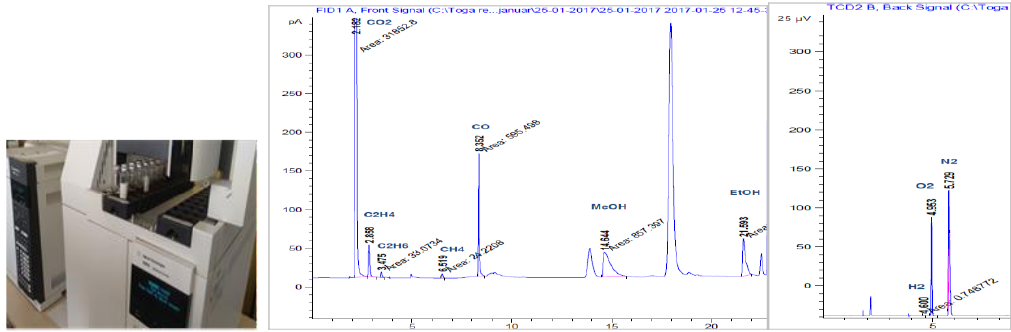
Figure 1. TOGA GC FID analyzer ( left ) and chromatogram of DGA and LMA ( right ).